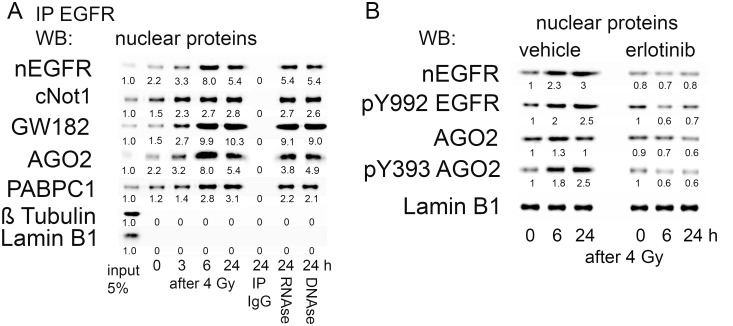
Interaction of nEGFR with members of the RISC.A: Immunoprecipitation of nEGFR in A549 cells. Detection of proteins involved in mRNA processing in complex with EGFR after irradiation with 4 Gy of radiation. Precipitates (24 h after IR) were treated either with 100 microgram/ml RNase A at 4°C for 1.5 h, or DNase I (50 U) for 30 min at 25°C. Beads were washed with PBS and denatured by adding protein sample buffer. Quantification of protein expression relative to input is shown. B: Inhibition of EGFR auto-phosphorylation and AGO2 phosphorylation after pretreatment with Erlotinib (2 micromolar/2 h) in the nuclear protein fraction of A549 cells. Representative results from three independent experiments are shown. We performed ANOVA followed by Tukey’s post hoc test to test for significant effects of Erlotinib on the data shown in Fig 3B. The effects of Erlotinib on nEGFR, pY992 EGFR, AGO2 and pY393 AGO2 expression were significantly different compared with the vehicle treatment (p<0.05).